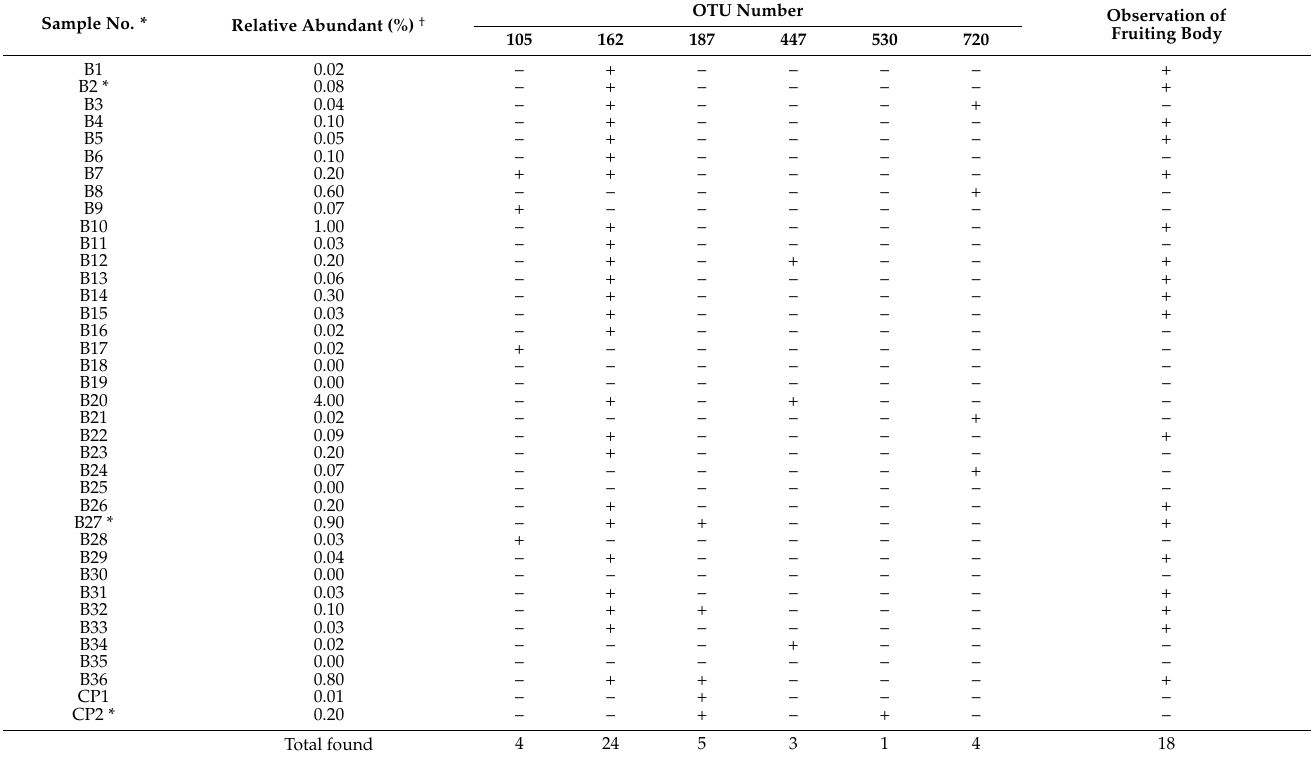
Table 1. Data of DNA sequences of Tuber species and fruiting body obtained from each soil sample.